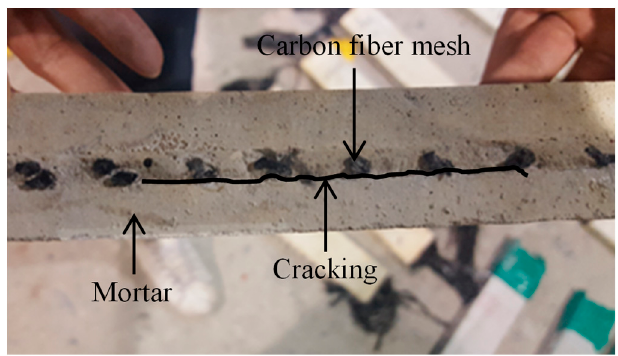
Figure 7. Crack pattern of a typical TRM test specimen following exposure to high temperature.